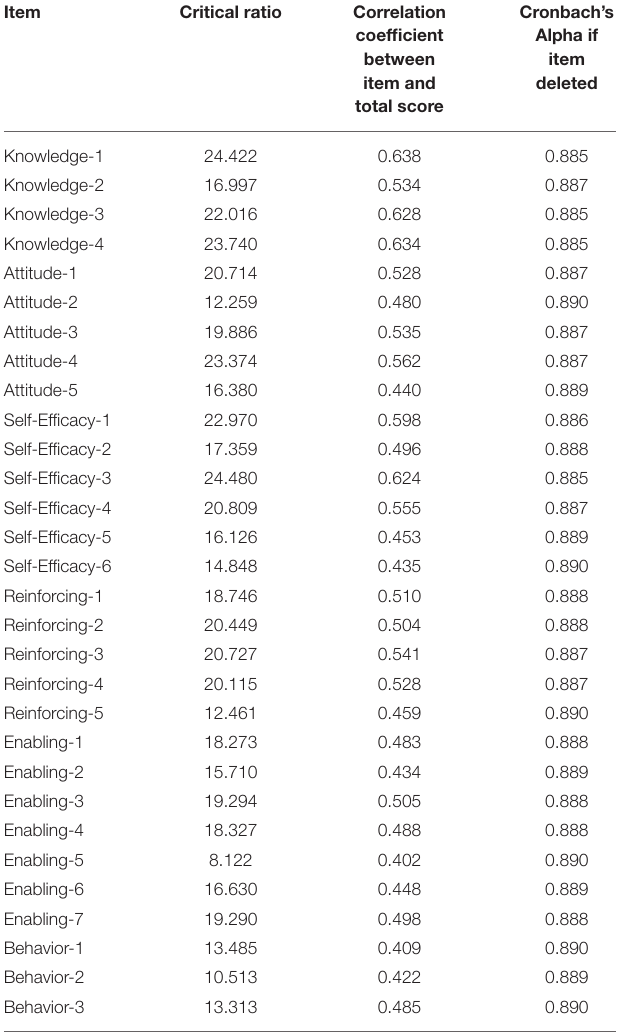
prevention behaviors questionnaire. Item Critical ratio Correlation